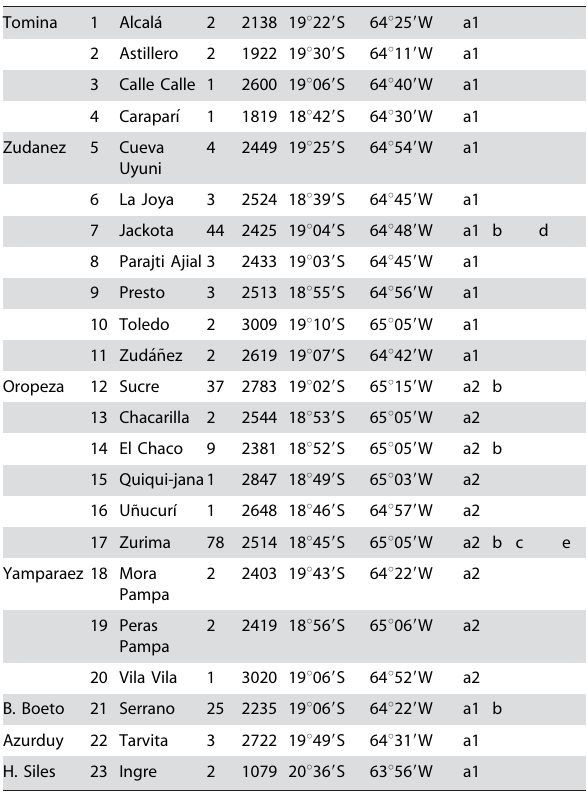
Table 1. Locations of the 23 populations of Triatoma infestans from Chuquisaca, Bolivia and their geographical and ecological